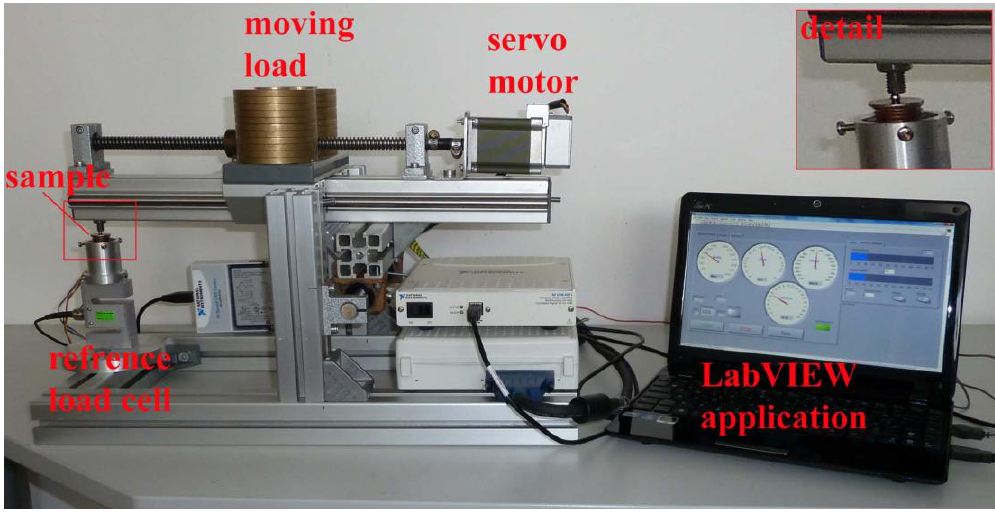
Figure 9. Measurement system for characterization of the hydraulic load cells. A detail of the test sample on the special holder is shown in the top-right-hand